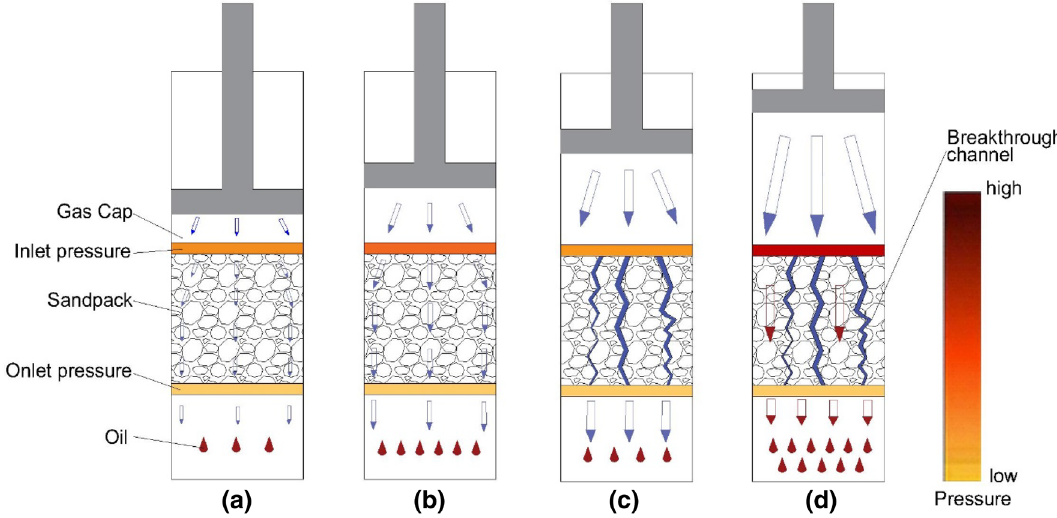
Fig. 4 The process of oil recovery changes with gas cap volume